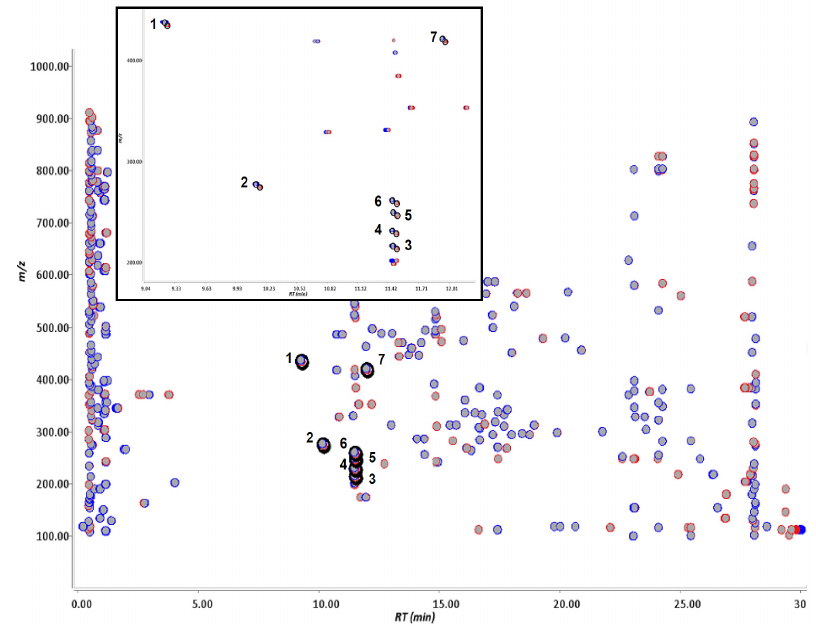
Figure 4. Ions detected by stable isotopic mass-shift filtering between deuterium-labeled and un-labeled flurbiprofen metabolized in human liver microsomes. The ions derived from un-labeled and labeled flurbiprofen were described in red and blue based on the mass spectrometric data, respectively. By comparing un-labeled ( red ) and labeled ( blue ) compounds, the particular ions having a specific mass-shift equal to 3 ± 0.03 Da were computationally filtered and visualized by being circled in black. Extended figures of captured ions are shown above.